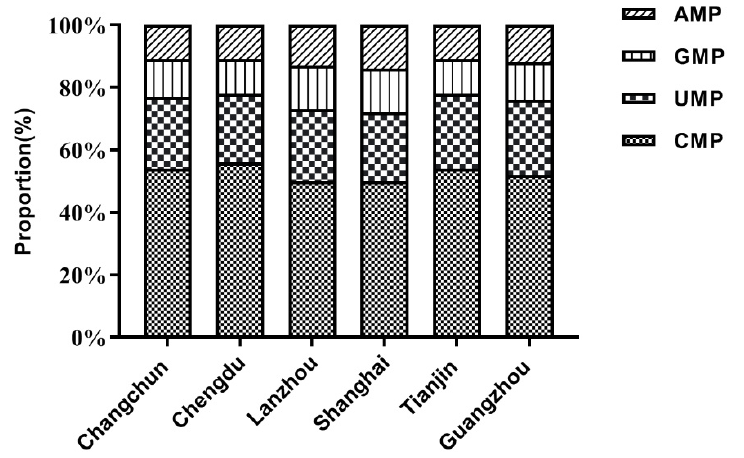
Figure 3. The proportion of total potential sources of nucleotides in the 6 regions. CMP, Cytidine monophosphate; UMP, uridine monophosphate; GMP, guanosine monophosphate; AMP, adenosine monophosphates.